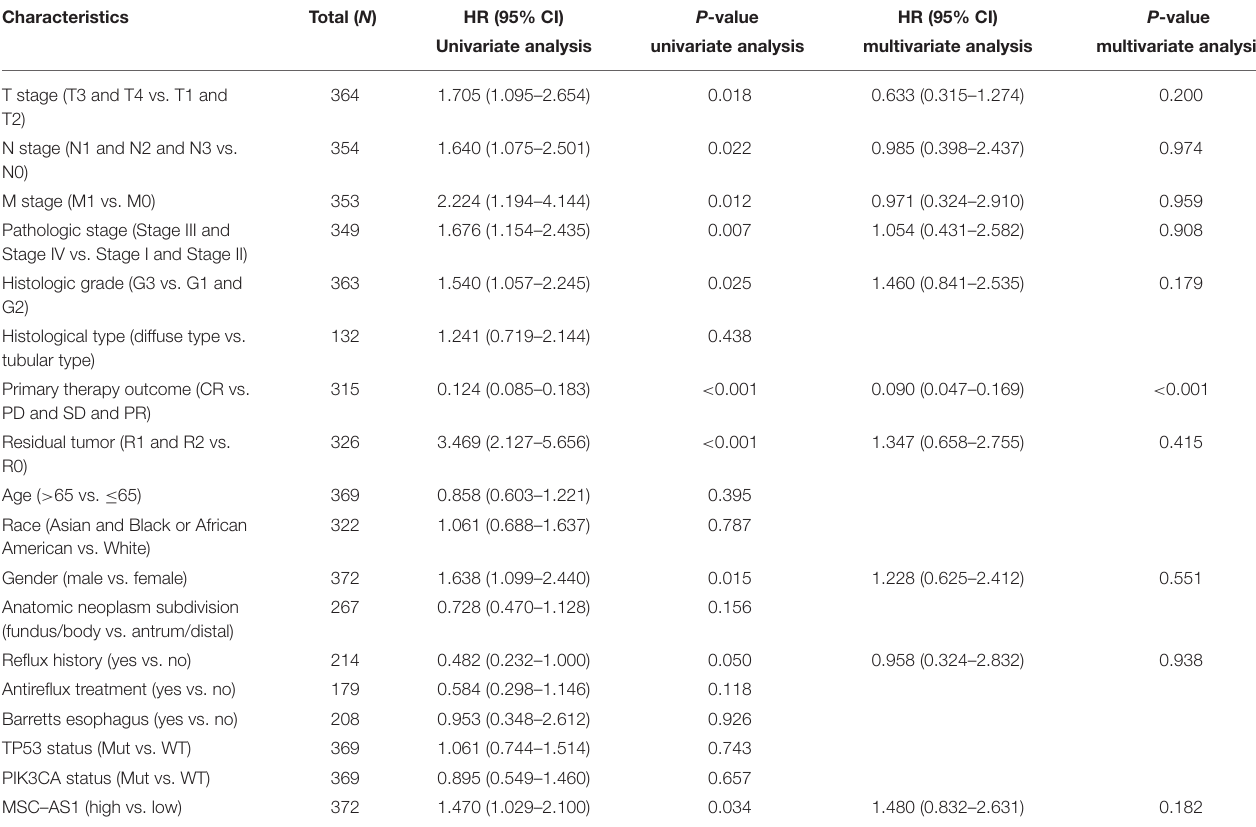
TABLE 5 | Associations between progression-free interval and clinicopathological characteristics in patients in TCGA using Cox regression.